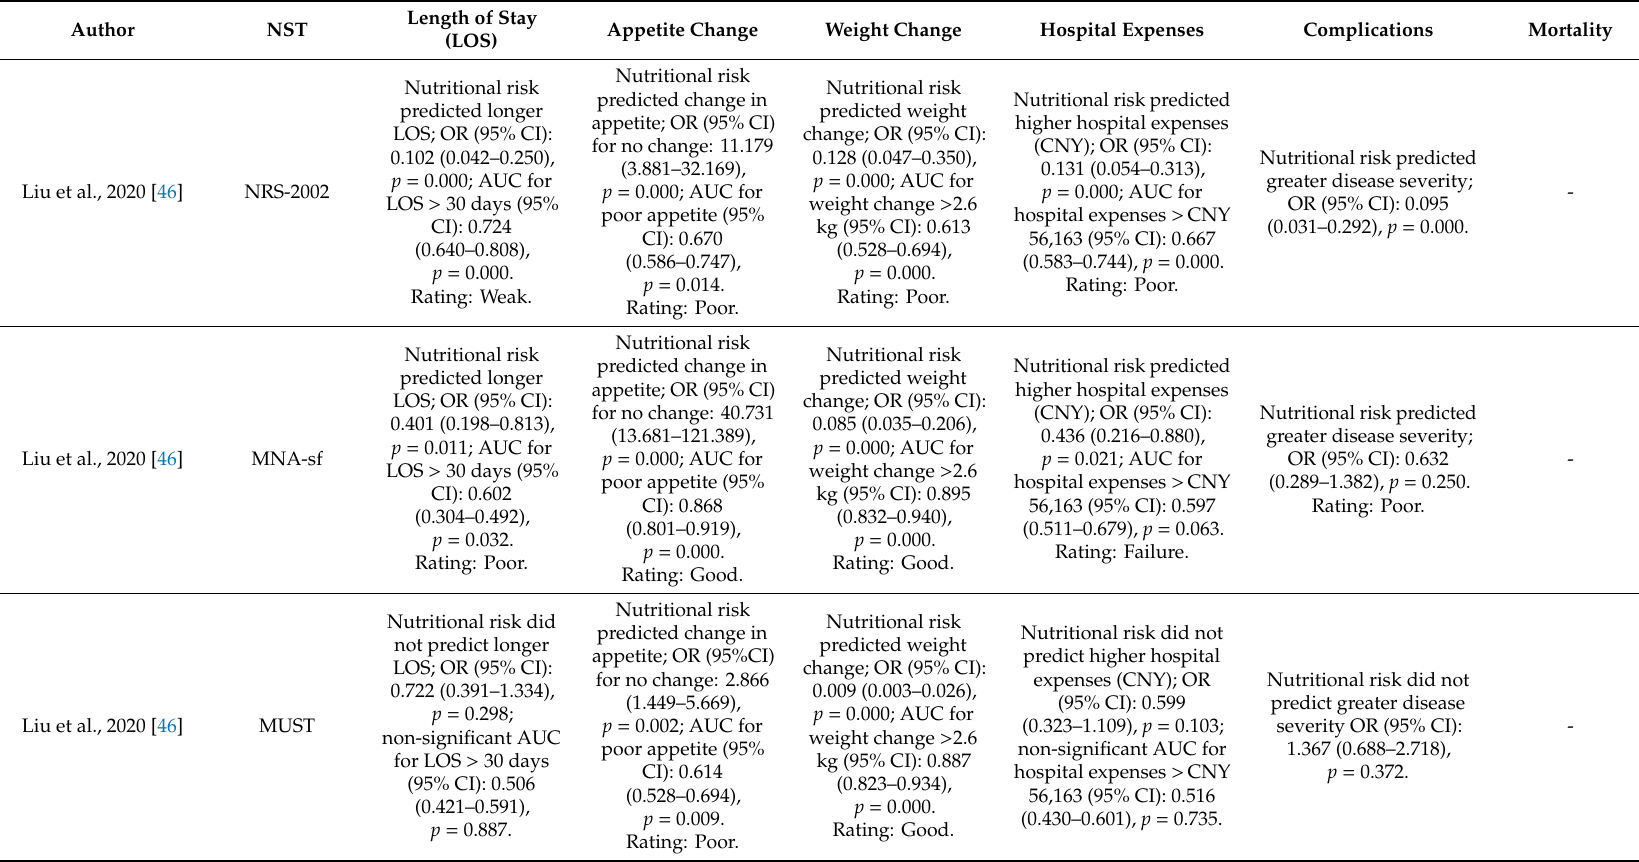
Table 6. Predictive validity of various tools used to evaluate nutritional risk or malnutrition in older adults with